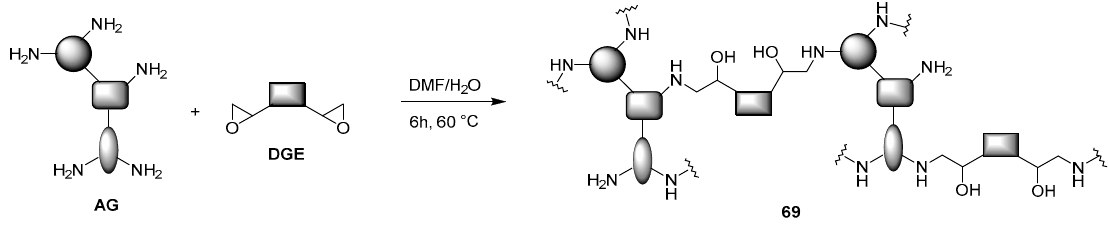
Figure 19. Synthesis of AG-DGE hyperbranched polymers 69 .